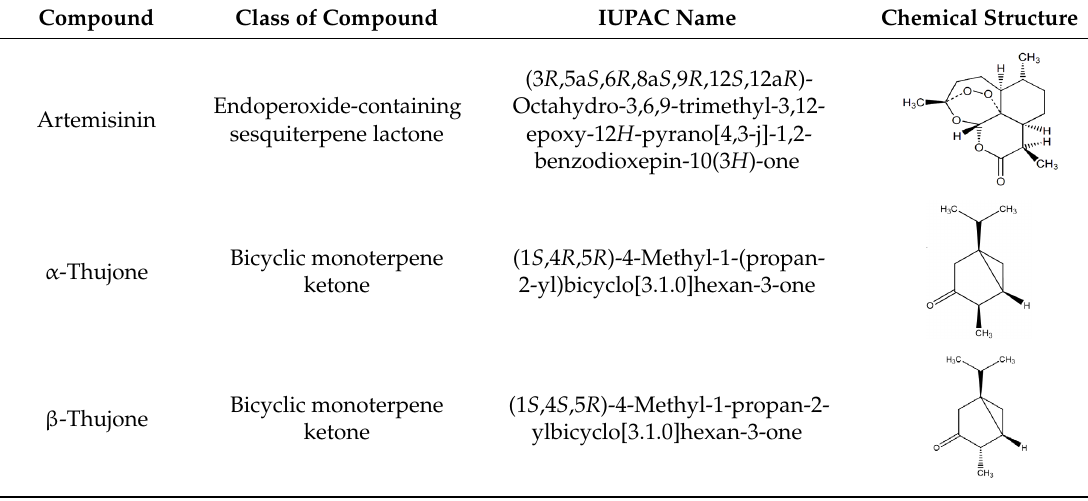
Table 2. International Union of Pure and Applied Chemistry (IUPAC) name, and chemical structure of bioactive molecules isolated from A. absinthium .